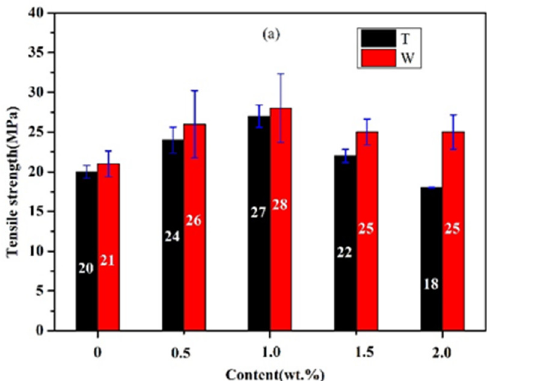
Figure 5. Variation curve of tensile properties of rubber-based composites with different contents of CGF. ( a ) tensile strength, ( b ) elongation at break.